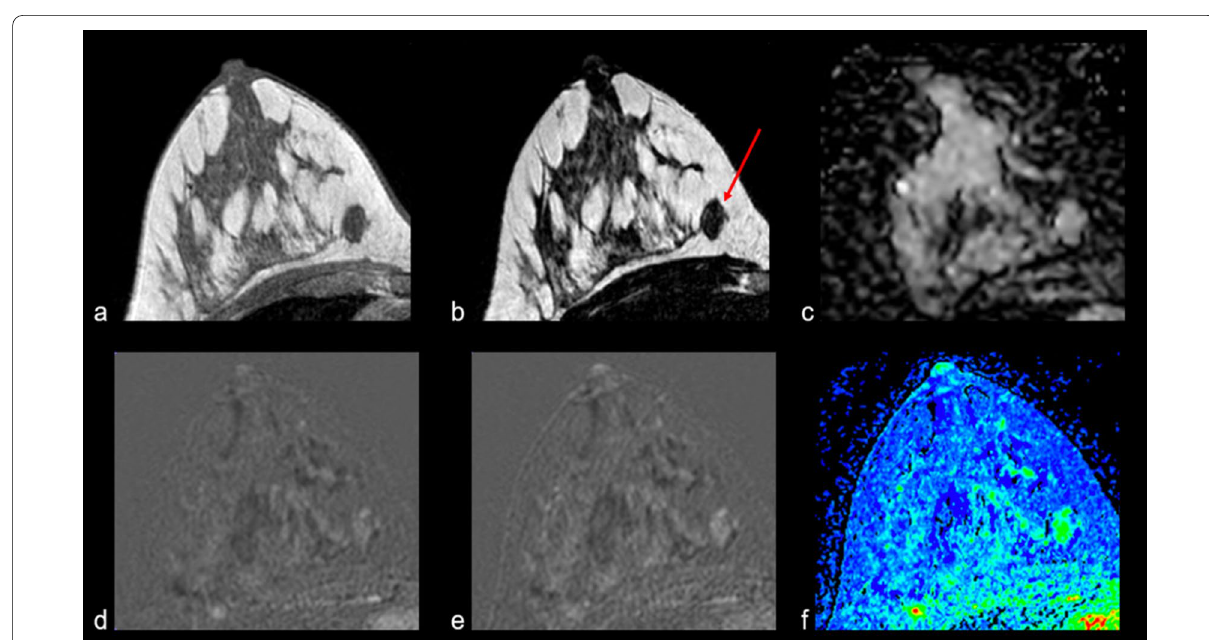
Fig. 3 Example of MRI finding of a previous BIRADS 4A echography examination. A 28‑year‑old patient with recent‑onset solid nodules in both breasts. Above: T1‑W axial ( a ), T2 VISTA axial ( b ) and ADC map ( c ) show a hypointense mass with regular contours and an ADC value about